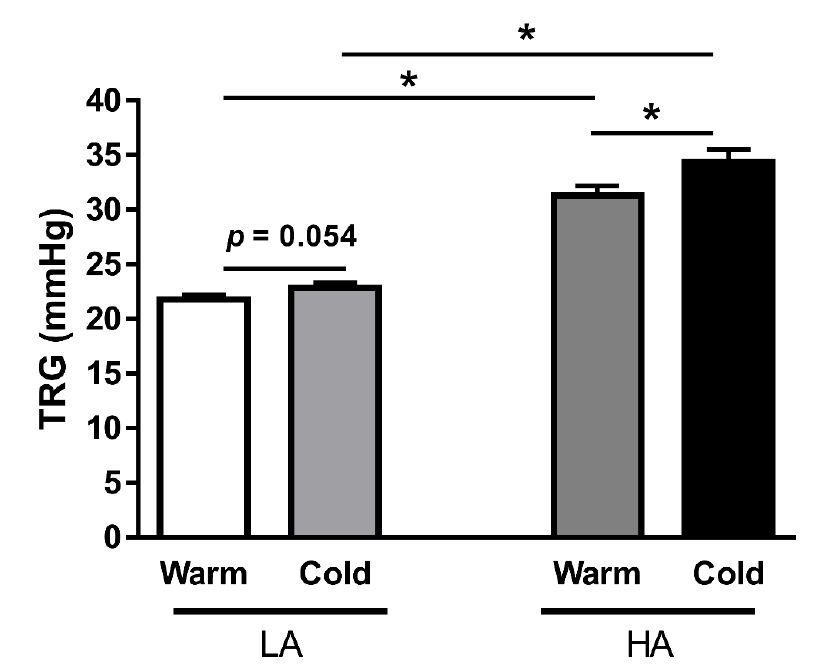
Figure 2. Effects of the long-term exposure to cold on pulmonary circulation in Kyrgyz lowlanders (LA) and highlanders (HA). TRG—tricuspid regurgitant systolic pressure gradient (in mmHg). Results are presented as mean ± SEM (n = 63–87). * p < 0.05 values are considered statistically signifi- cant.